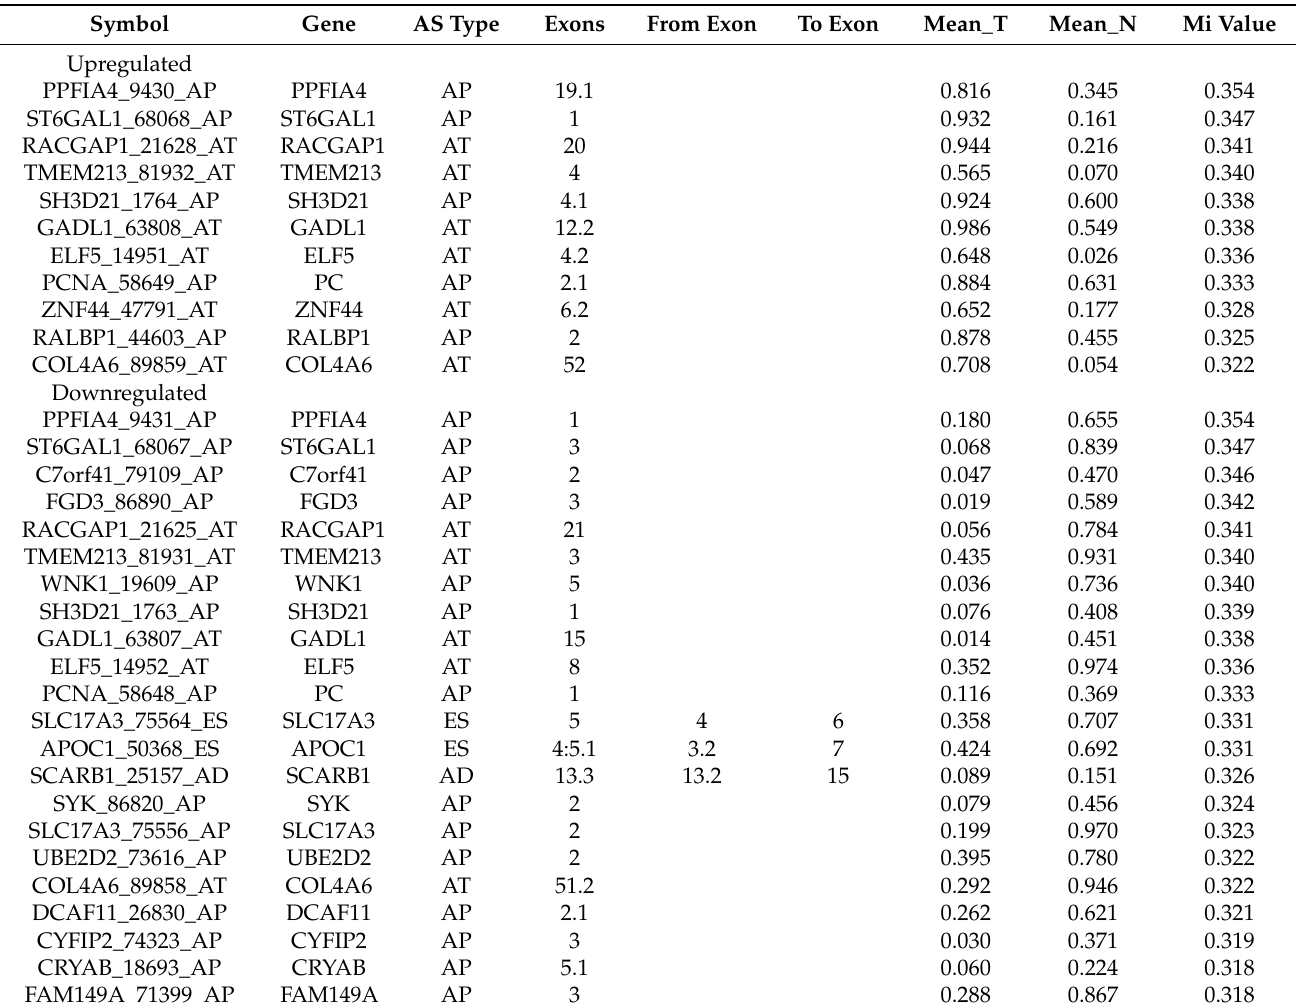
Table 1. Detailed information of 33 cancer-specific